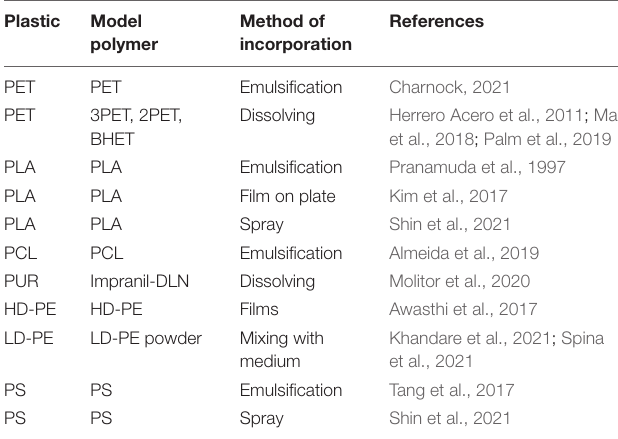
TABLE 2 | Overview of methods for screening and identification of plastic